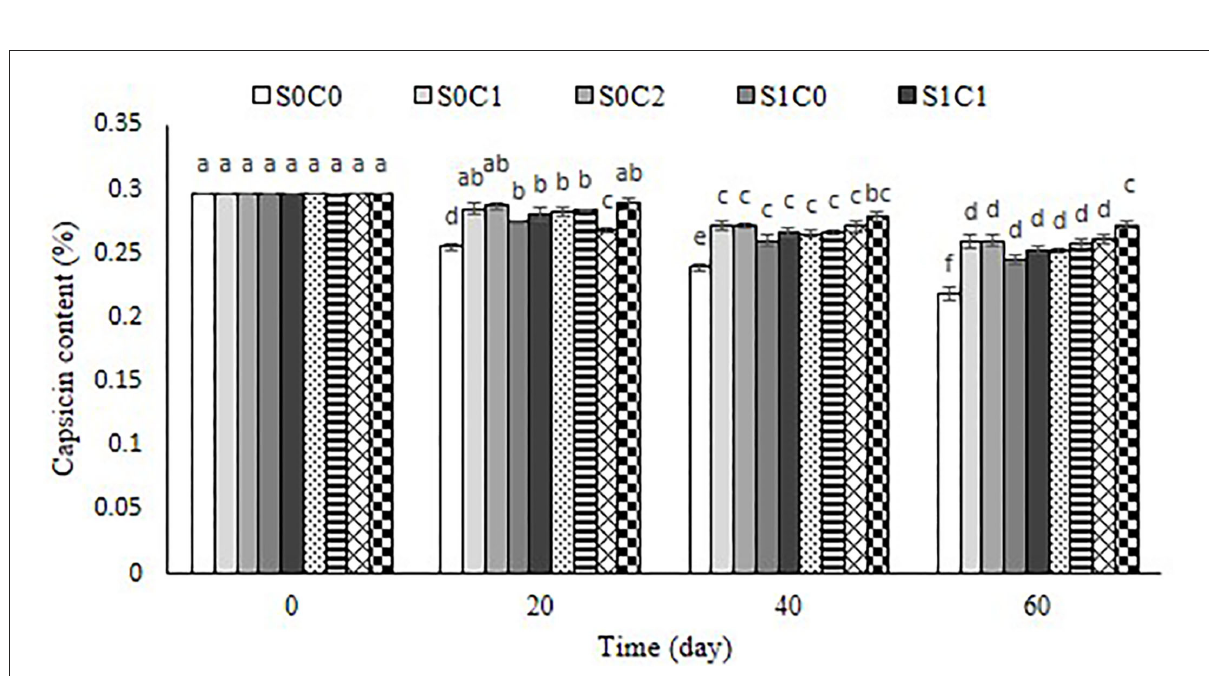
FIGURE10 Effect of foliar spraying of SA and caraway oil coating on capsaicin content (%) during 60 d of storage at 4 ± 2 ◦ C plus shelf life (2 d, 20 ◦ C). S0C0: control, S0C1: 0.3% caraway oil, S0C2: 0.6% caraway oil, S1C0: 1.5mM Salicylic acid, S1C1: 1.5mM Salicylic acid + 0.3% caraway oil, S1C2: 1.5mM Salicylic acid + 0.6% caraway oil, S2C0: 3mM Salicylic acid, S2C1: 3mM Salicylic acid + 0.3% caraway oil, S2C2: 3mM Salicylic acid + 0.6% caraway oil. Values represent mean ± SD of three replications. Different letters indicate significant differences at the 5% level according to the Duncan